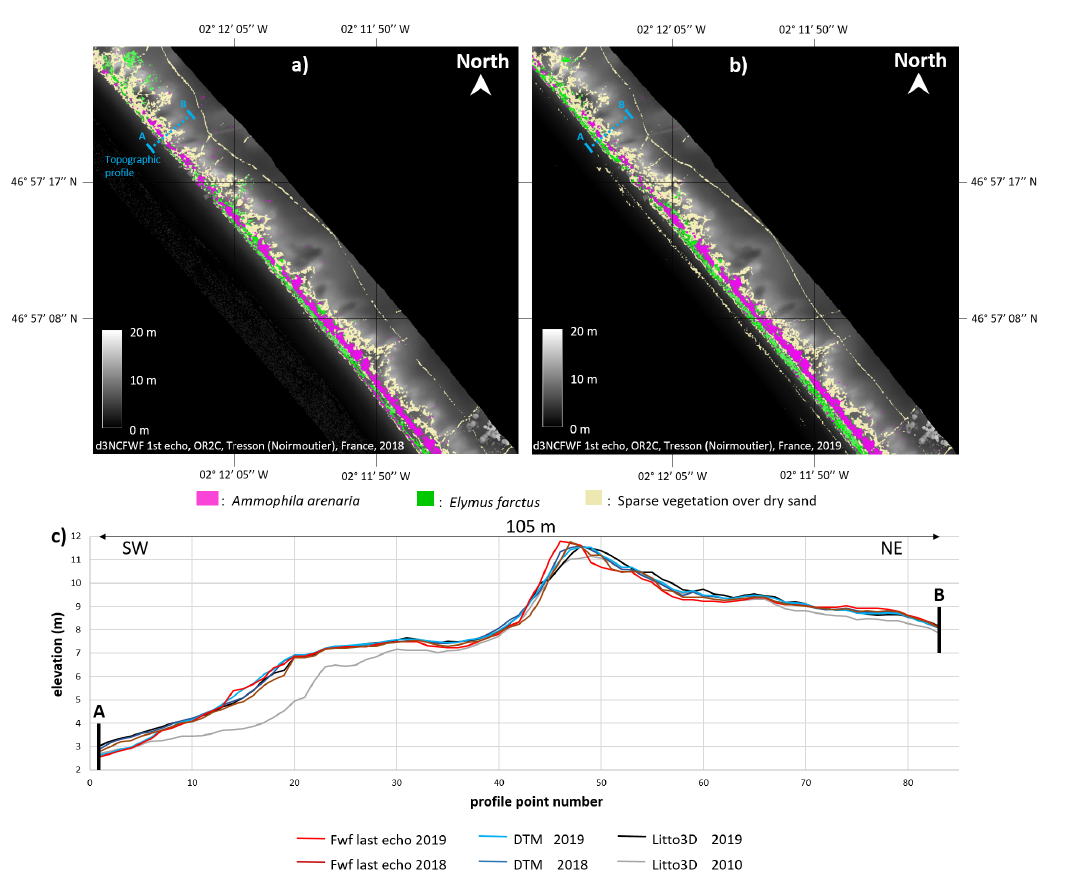
Figure 13. Tresson training area of d3NCFWF 1st echoes DSM with marram height correction in ( a ) 2018 and ( b ) 2019 with maps of Ammophila arenaria ( magenta ), Elymus farctus ( green ), and sparse vegetation over dry sand ( light yellow ). Light blue dotted lines represent the position of the profile represented in ( c ), which are corrected FWF last echoes of 2018 ( dark red ) and 2019 ( light red ), discrete echoes DTM of 2018 ( dark blue ) and 2019 ( light blue ), and IGN Litto3D data of 2010 ( grey ) and 2019 ( black